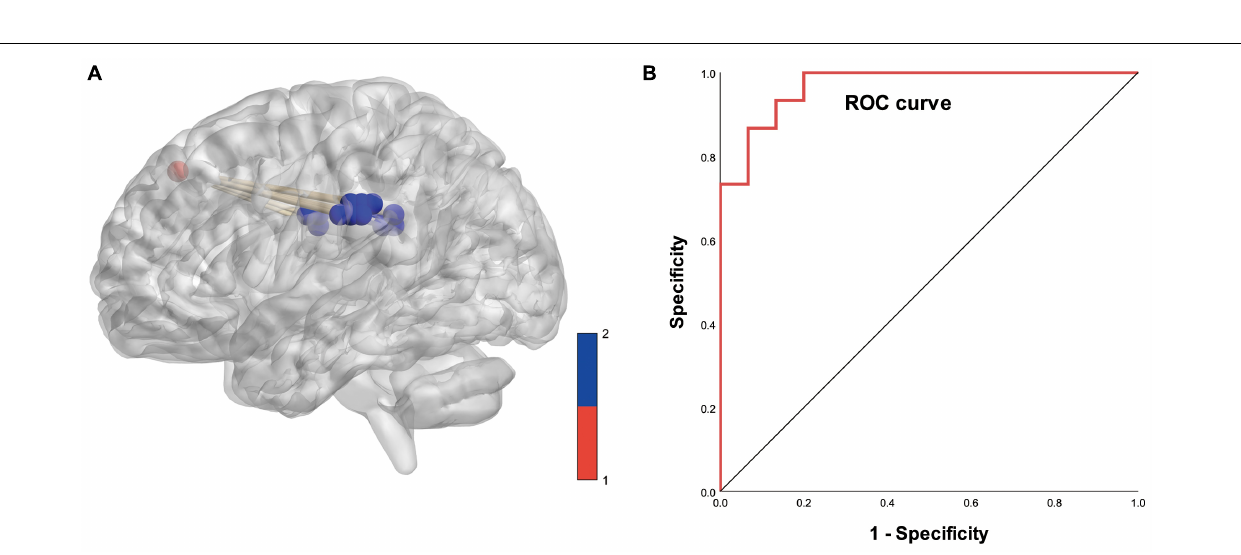
FIGURE 6 | (A) Diagram of functional covariance connections between the right dorsolateral prefrontal cortex and white matter. Red spheres represent gray matter voxels in the right dorsolateral prefrontal cortex, and blue spheres represent white matter voxels. (B) ROC curve based on the connections between the right dorsolateral prefrontal cortex and white matter voxels (area under the curve is 0.969).